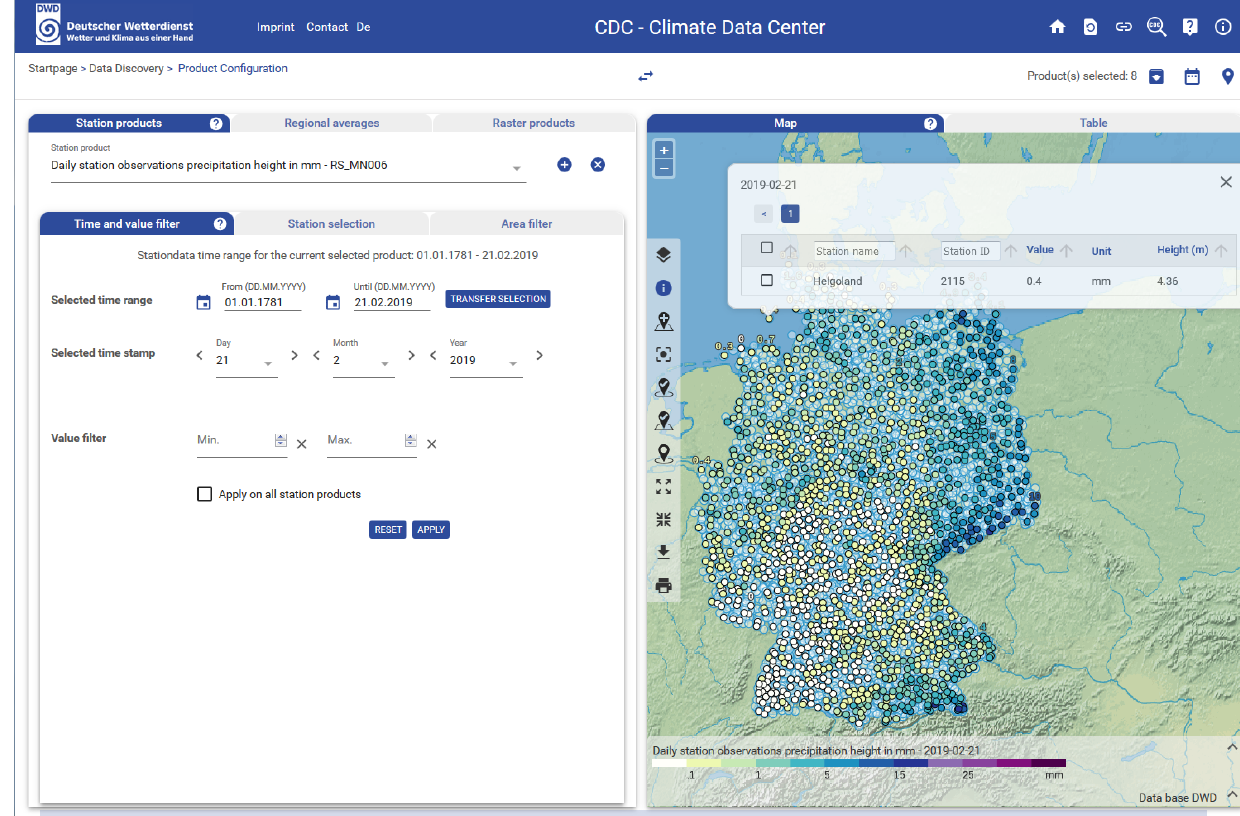
lution, geographical region, unit, maintenance frequency